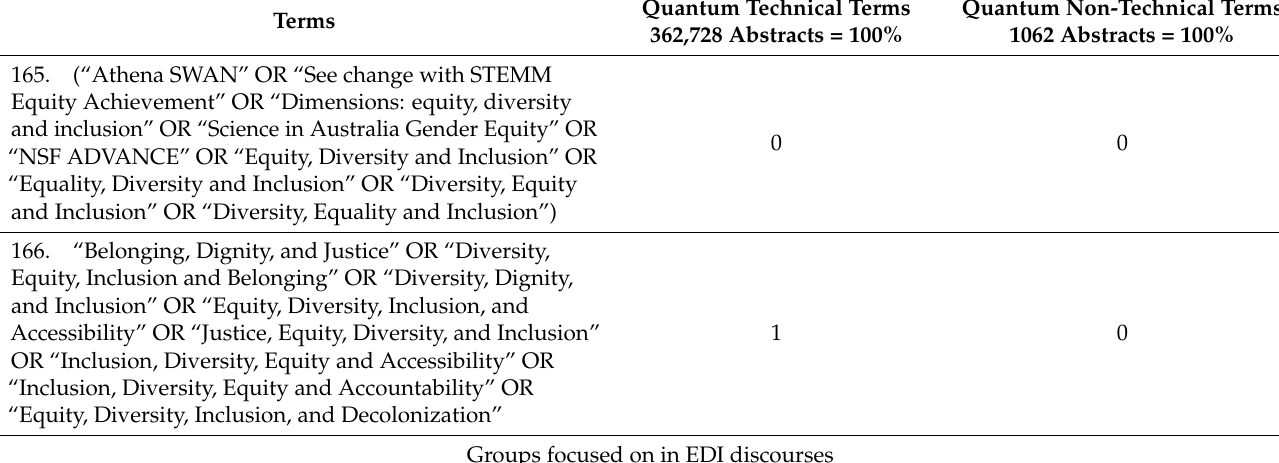
Table 9. Presence of EDI terms in the academic literature focusing on quantum